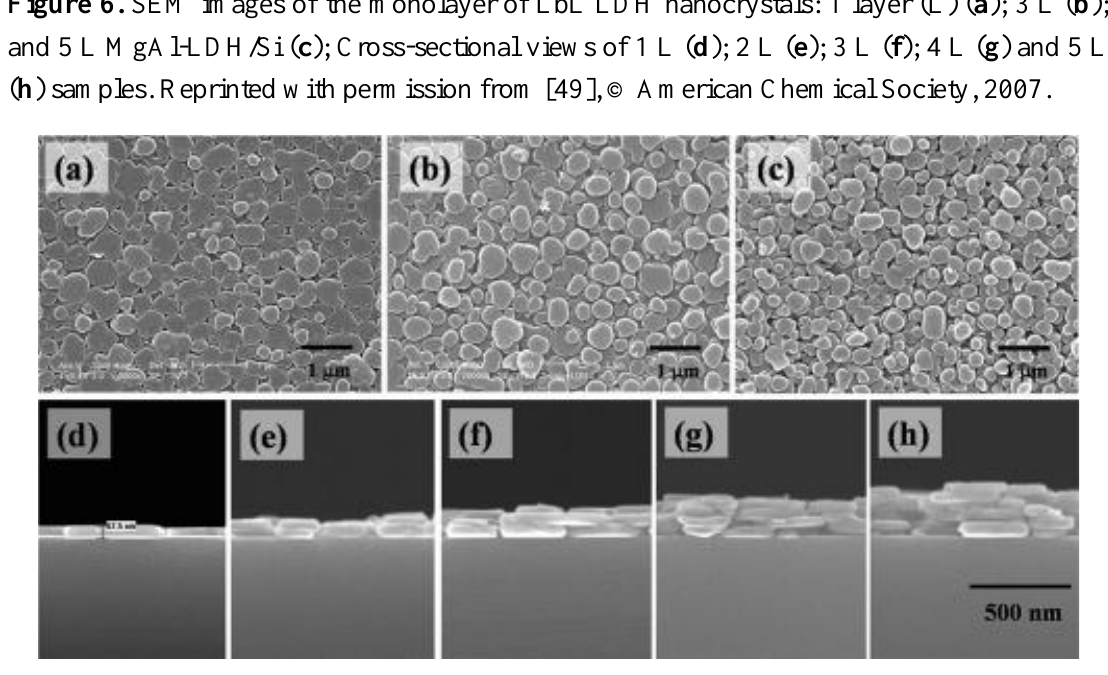
Figure 7. Schematic illustration of the possible delamination mechanism for LDHs in formamide, which were used as positively charged building block to prepare multilayer film of (LDH/PSS)n assembled on a quartz glass substrate. Reprinted with permission from [58], © American Chemical Society,